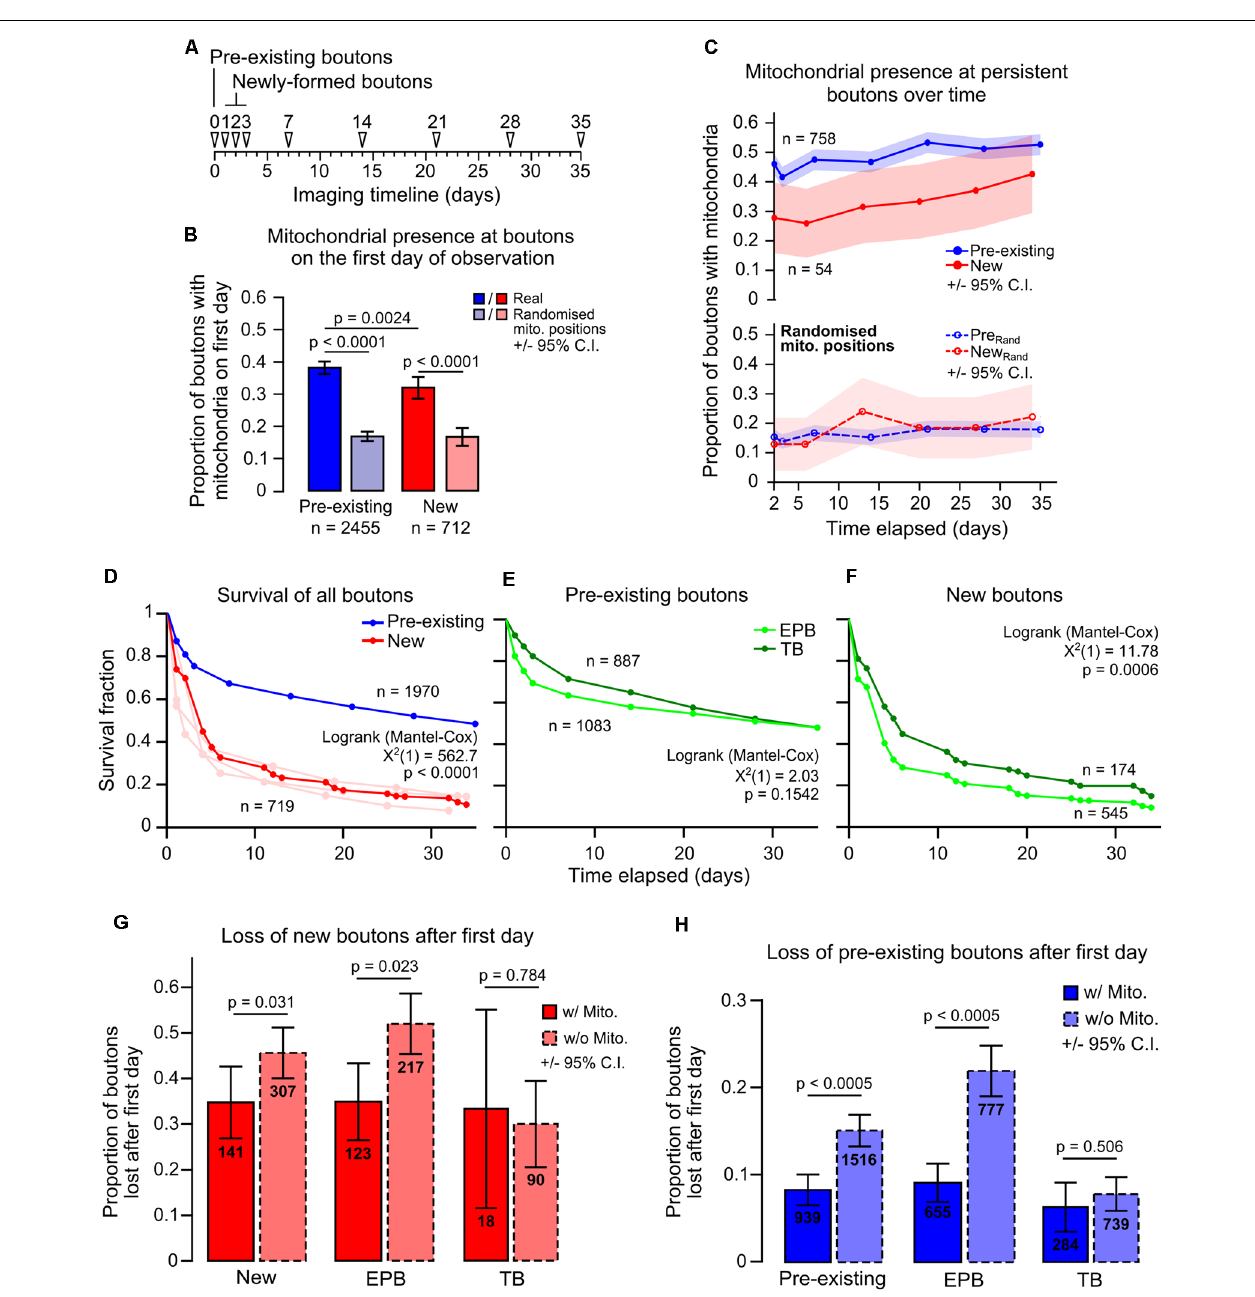
FIGURE 4 | Mitochondrial presence at individual boutons is positively related to bouton age and longevity. ( A ) Timeline indicating the classification of pre-existing boutons (first identified on day 0) and newly-formed boutons (first identified on days 1, 2 or 3). (B) Pre-existing boutons were more likely to have mitochondria ( < 1.5 µ m) than newly-formed boutons (Chi-squared test). Newly-formed boutons had more mitochondria present than with randomized positioning of mitochondria, as did pre-existing boutons (Chi-squared test). Error bars ± 95% CI. (C) Boutons that persisted in every time point after day 2 (after all newly-formed boutons were identified) had their mitochondrial localization tracked. Pre-existing boutons showed a significant increase in mitochondrial presence (Cochran’s Q test: χ 2 ( 6 ) = 51.359, p < 0.0005). New boutons also showed an increase; however, this was not statistically significant (Cochran’s Q test: χ 2 ( 5 ) = 6.81, p = 0.235). When mitochondrial positions were randomized, both new and pre-existing boutons did not show significant increases in mitochondrial localization (Cochran’s Q test: New, χ 2 ( 5 ) = 3.807, p = 0.578; pre-existing, χ 2 ( 6 ) = 9.787, p = 0.134). Shaded areas are ± 95% CI. (D) Survival of boutons was measured as the time until bouton loss. Pre-existing boutons were significantly more stable than new boutons (Log-rank test). The new bouton population was pooled from day 1–3 (light red lines). (E,F) Of the pre-existing population, TB and EPB survival was similar (E) , however, there was a small significant decrease in survival for new EPBs compared to TBs ( F ; Log-rank test). (G) The proportion of new boutons with or without mitochondria that were lost after their first day. There was a significant decrease in bouton loss when mitochondria were present at new boutons (Fisher’s exact test). This relationship was due to the population of EPBs and not TBs. (H) Similarly, pre-existing EPBs with mitochondria were half as likely to be lost when compared to those without mitochondria (Fisher’s exact test). Error bars ± 95% CI.